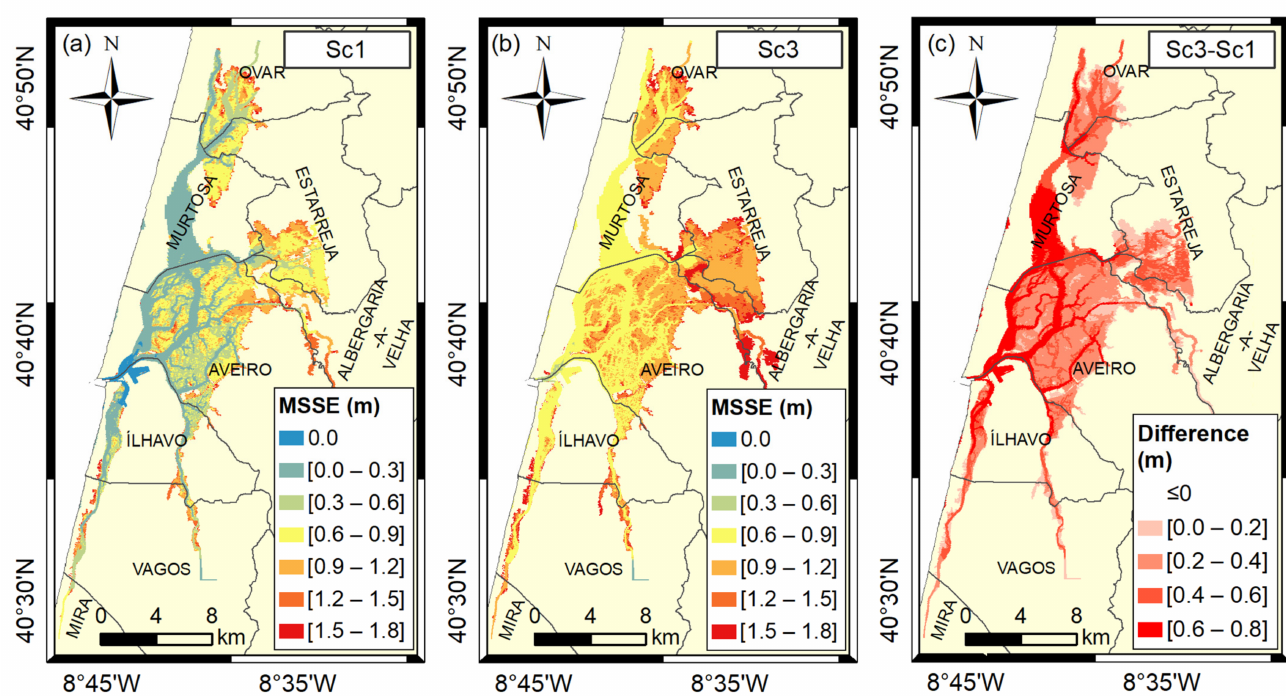
Figure 5. Mean sea surface elevation in the Ria the Aveiro under present MSSE ( a ) and future MSSE ( b ). The difference between the results for the two scenarios ( c